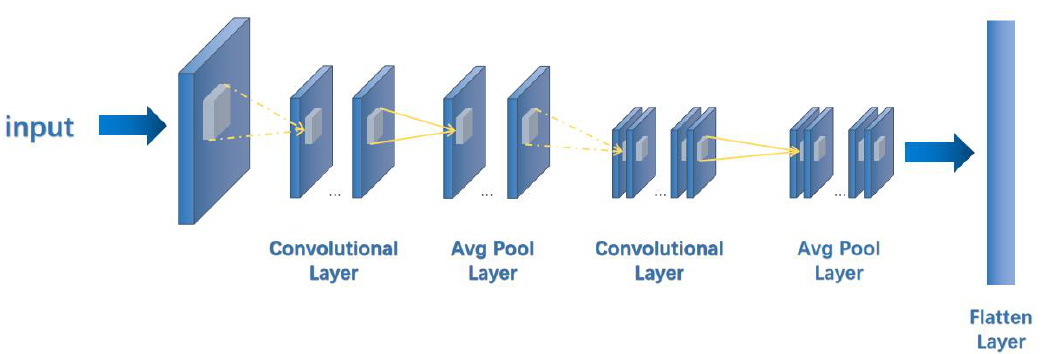
Figure 4. The 2048 bit 2D Morgan Fingerprint Feature Extraction Network. The dashed line shows the convolution process, and the solid line shows the pooling process.